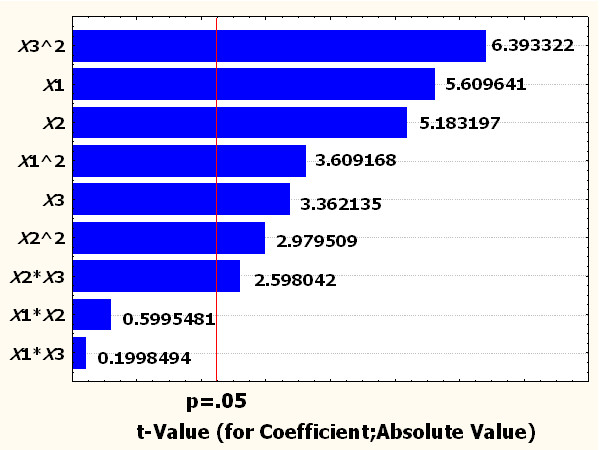
Pareto chart of t-values for coefficients.